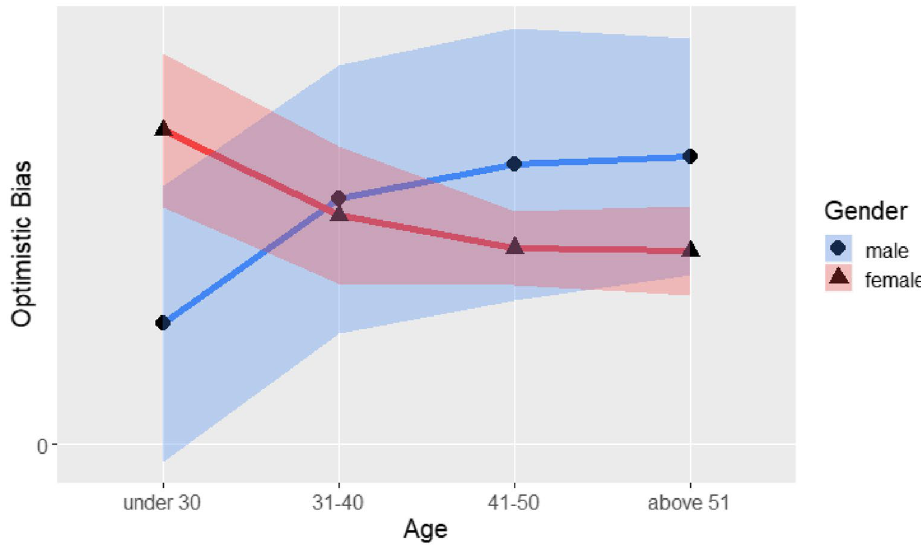
Figure 4. Optimistic bias score by gender and age.